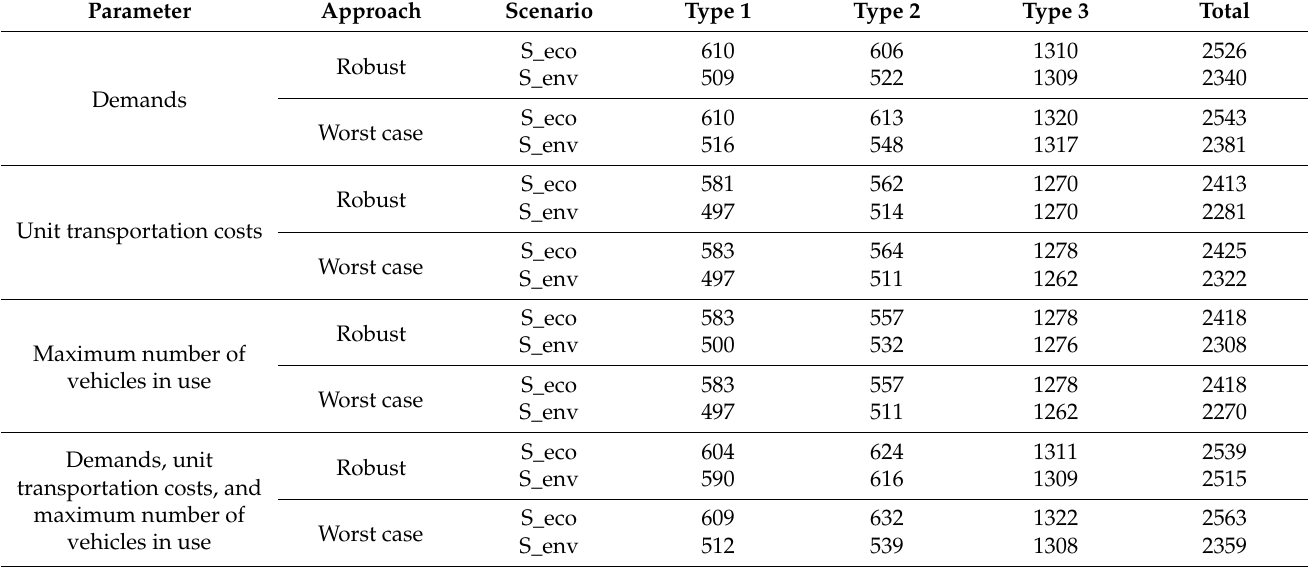
Table 10. Number of vehicles in use.